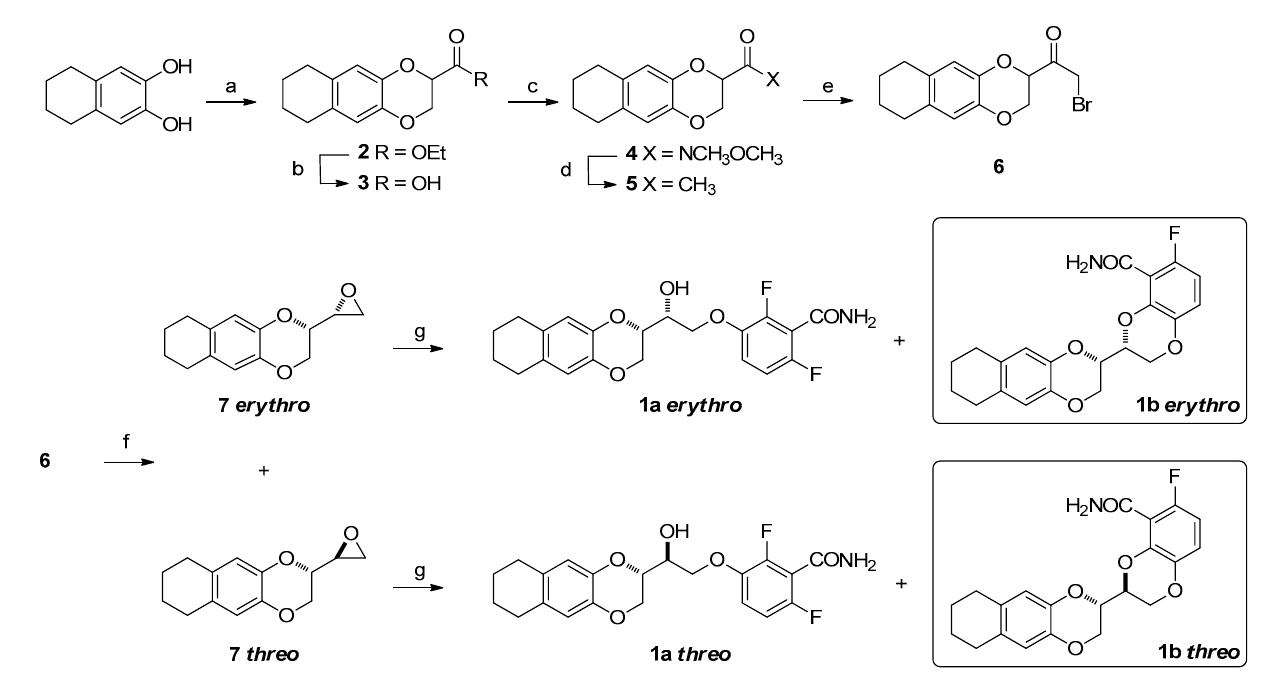
Scheme 1. Synthetic pathway for the obtainment of both 1a and 1b . Reagents and conditions: (a) Ethyl 2,3-dibromopropionate, K 2 CO 3 , DMF, 70 °C, 1 h; (b) 10% aqueous NaOH, MeOH, RT, 30